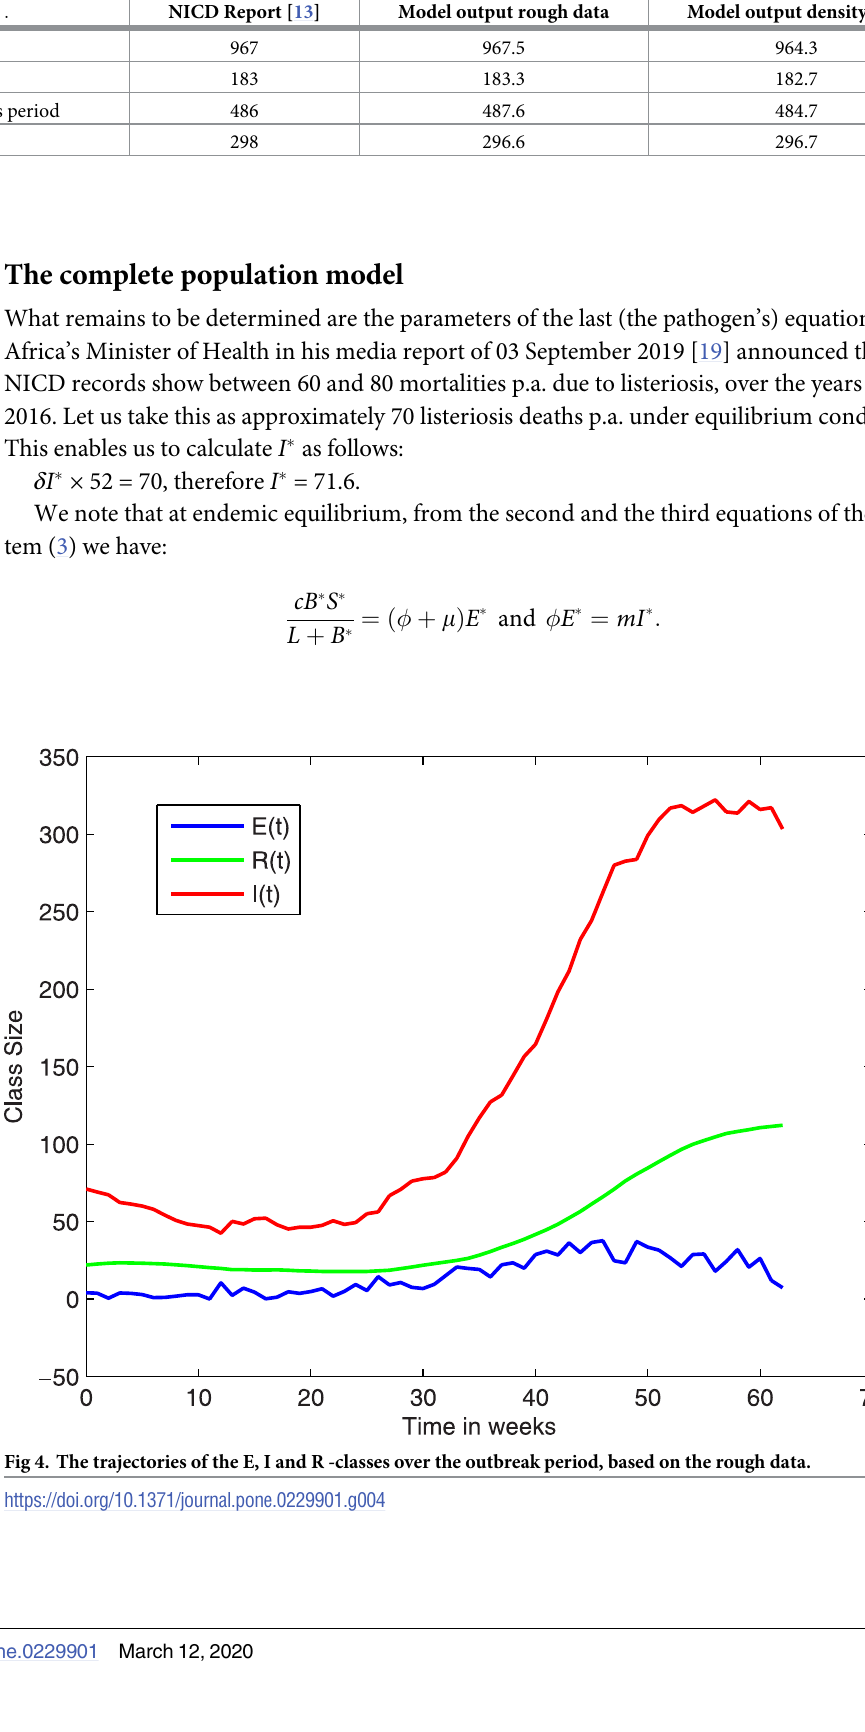
Table 2. The model output versus observed data. Total number of individuals who